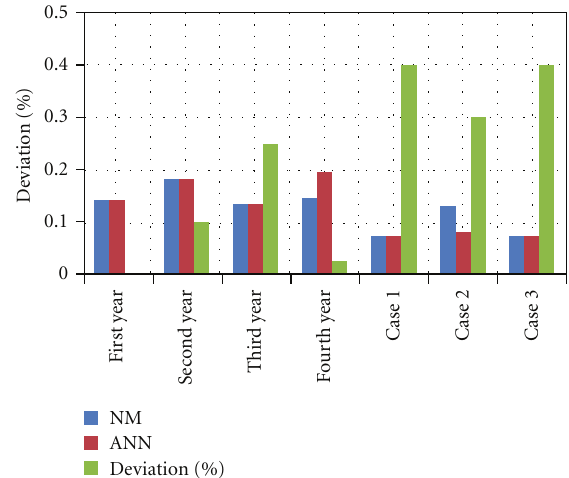
Figure 3: SAIFI values for feeder X12 with deviation less than